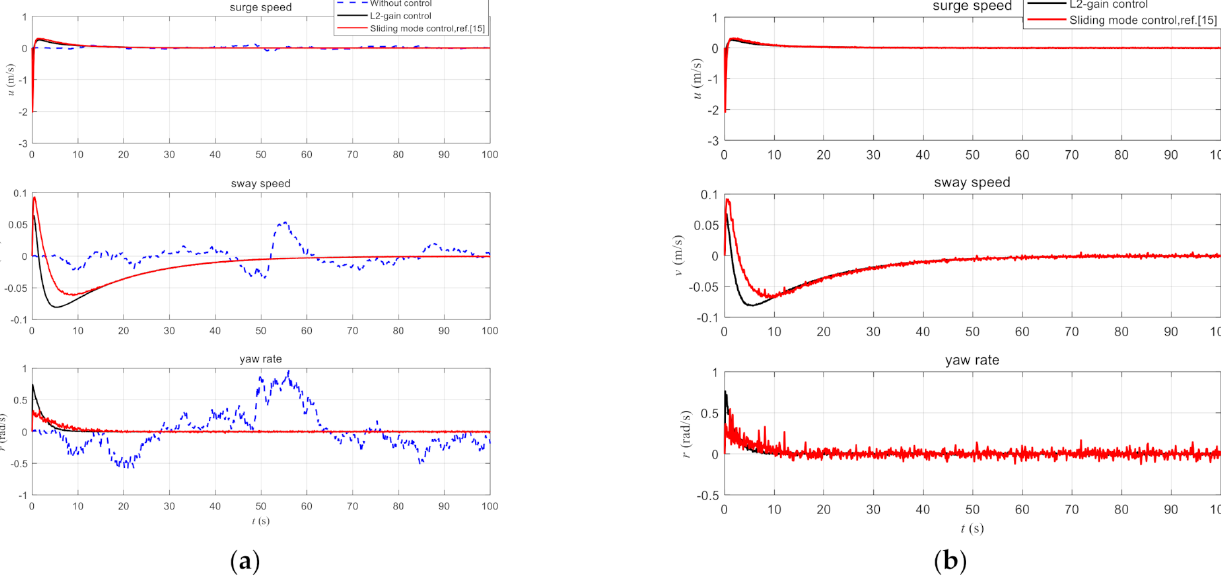
Figure 6. Velocities of the surface ship. ( a ) Disturbances at the level of 0.5*randn; ( b ) disturbances at the level of